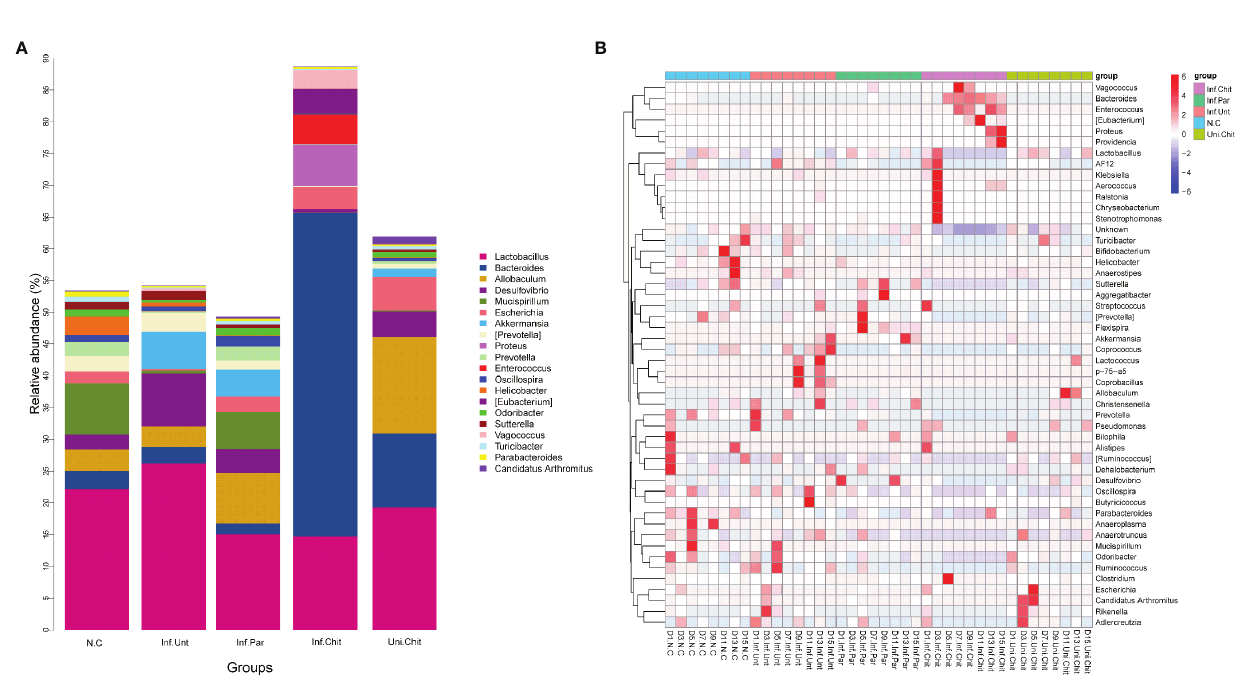
FIGURE 8 | Chitosan treatment modulated gut microbiota at the genus level in mice infected with C parvum . (A) Histogram represents the relative abundance of the top 20 microbial genera in the feces of mice from the fi ve groups. (B) Heatmap indicate the top 50 microbial genera based on UPGMA clustering method and Bray – Curtis distance metric for C parvum -infected mice given different treatments at different